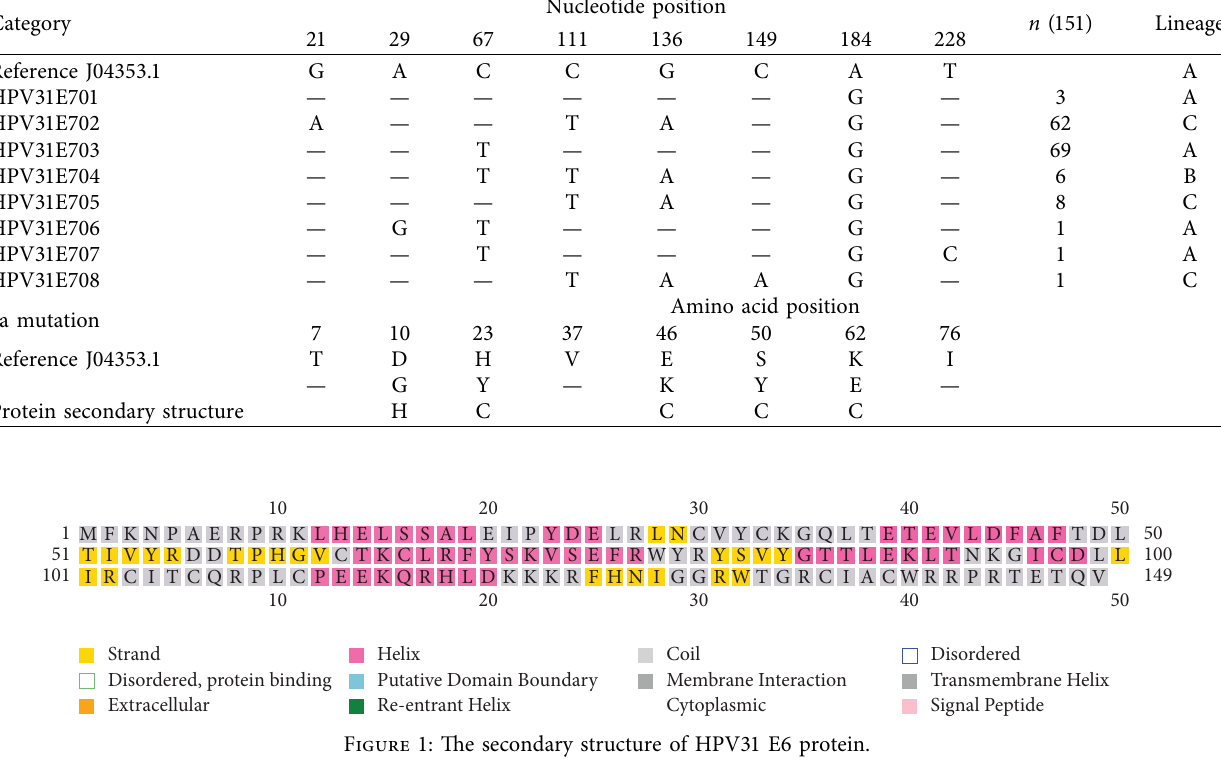
Figure 1: Te secondary structure of HPV31 E6 protein.